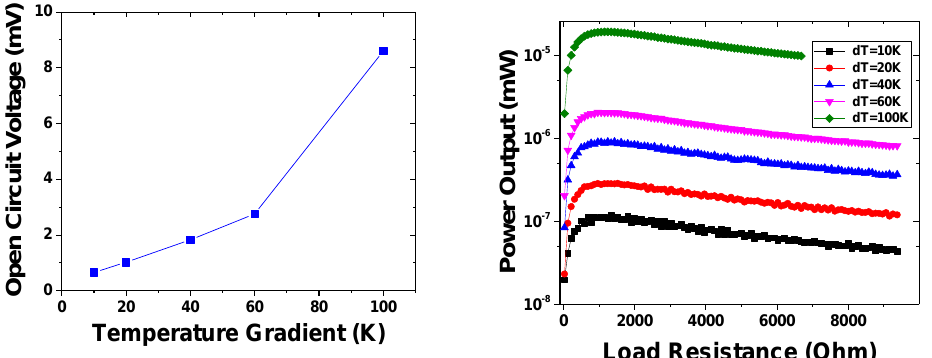
Figure 7. The output voltage in open circuit (left) and the power output for different loads (right).